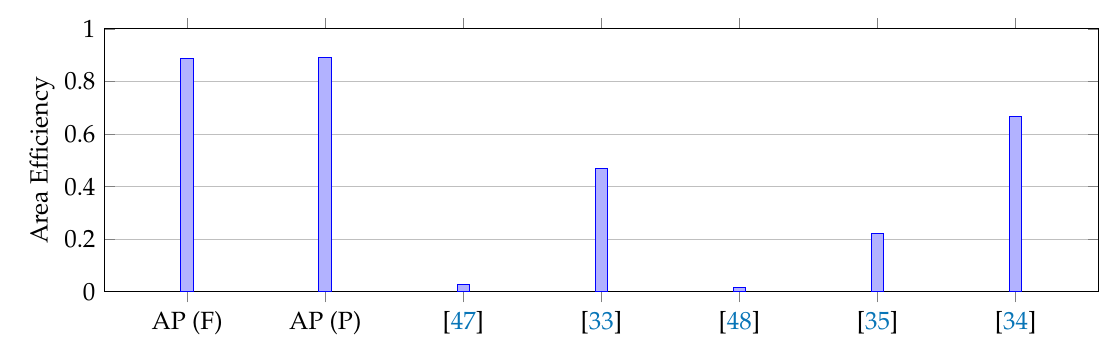
Figure 9. Area efficiencies of FFT processors (GS/s/mm 2